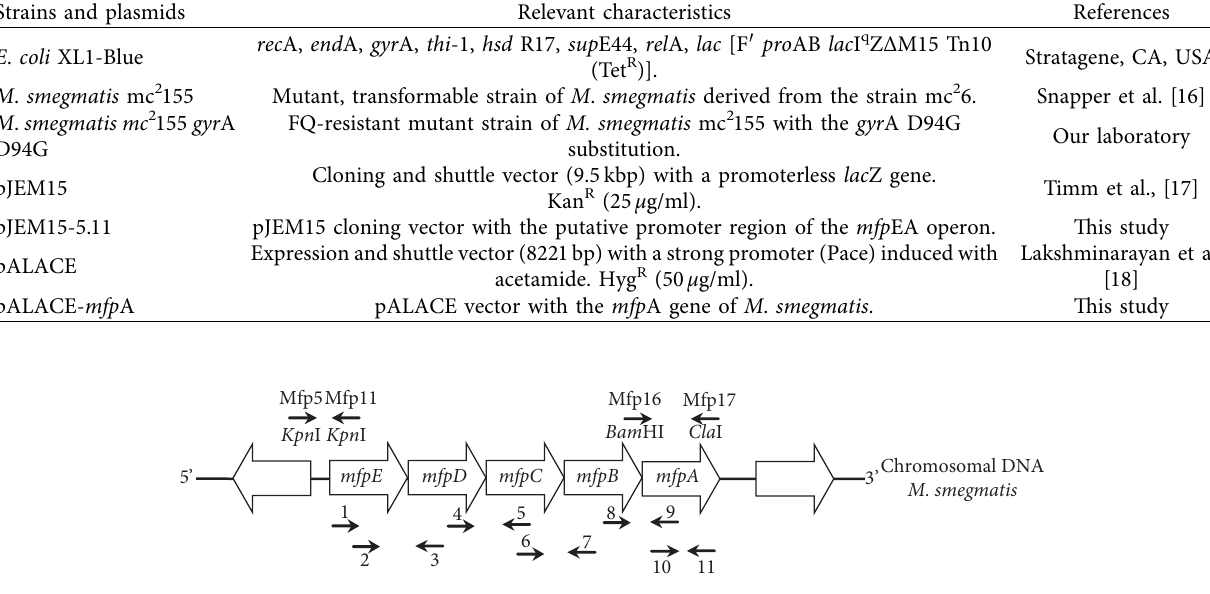
Table 1: Strains and plasmids used in this